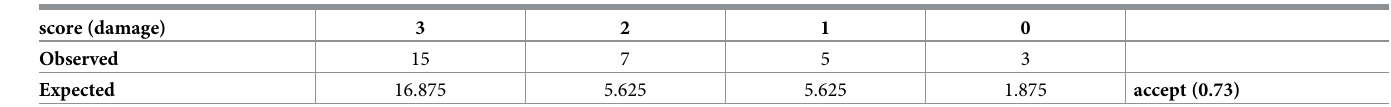
single major gene controlled the difference in freezing survival between these two biotypes, only phenotypes identical to the parents in regards to freezing survival would be expected. The results below are closest to what is expected from a single major gene controlling freezing sur- vival (Fig 3). Because there are too many plants with a 0 rating (110 observed with an expected of 63.5), too many with little to no apparent damage (94 observed with an expected of 63.5) and too few plants had intermediate scores, the ratio does not pass a Chi Square test for a 1:1:1:1 ratio. Also, because a discontinuous scoring scale can skew interpretation of results by arbitrarily binning individuals into a small number of classes, we also examined chlorophyll florescence (Fv/Fo and Fv/Fm) as a measure of damage (Fig 4 and Fig 5 respectively). The Fv/ Fo and Fv/Fm values, which are very sensitive detectors of stress, more clearly indicated two major clusters of about equal number, with a few intermediate phenotypes. Although these data are consistent with a small number of genetic differences influencing freezing survival dif- ferences in the two biotypes, it more closely supports a single major gene impacting the pheno- type with possibly a number of genes that have only minor influences on the phenotypes of individuals from the original cross. Table 1. Chi square analysis from 30 F2